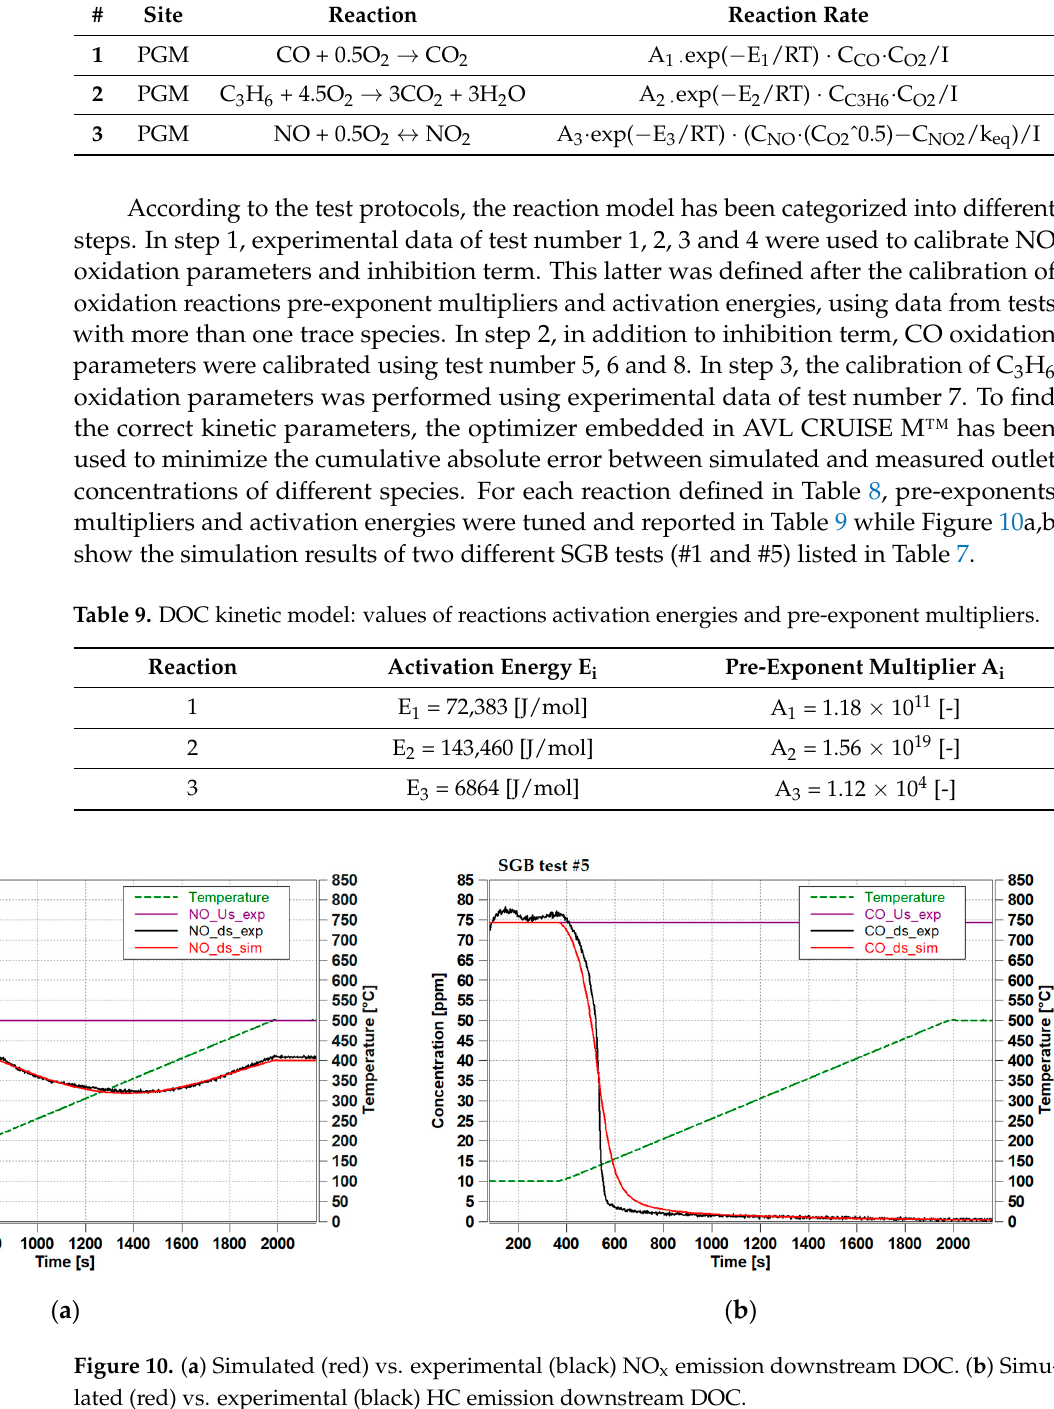
( b ) Figure 11. ( a ) Top: Simulated (red) vs. experimental (black) NO x emission downstream DOC. Bot- tom: Simulated (red) vs. experimental (black) NO emission downstream DOC. ( b ) Top: Simulated (red) vs experimental (black) HC emission downstream DOC. Bottom: Simulated (red) vs experi- mental (black) CO emission downstream DOC.